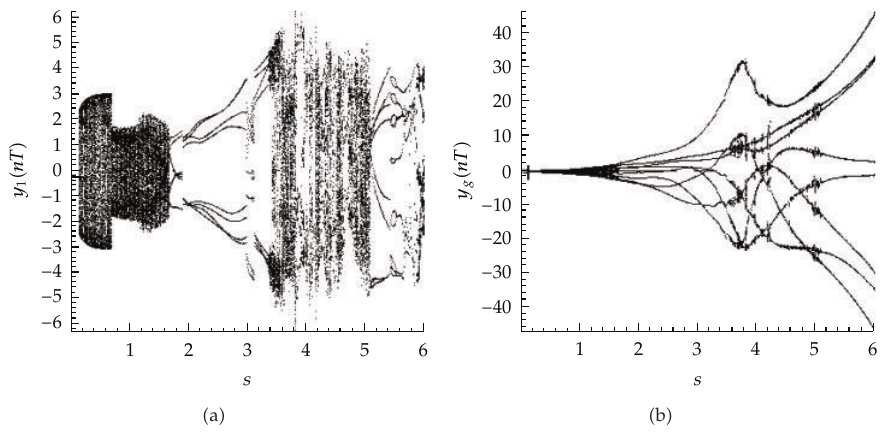
Figure 3: Bifurcation diagrams of gear-bearing system using dimensionless rotational speed ratio, s , as bifurcation parameter for non-Newtonian lubricating fluid with l ∗ (cid:9) 0 .